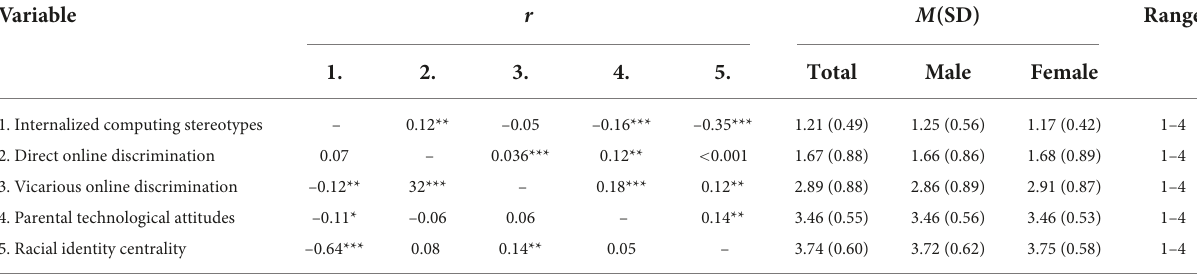
TABLE 1 Descriptive statistics and correlations of main continuous variables of interest by adolescent gender.